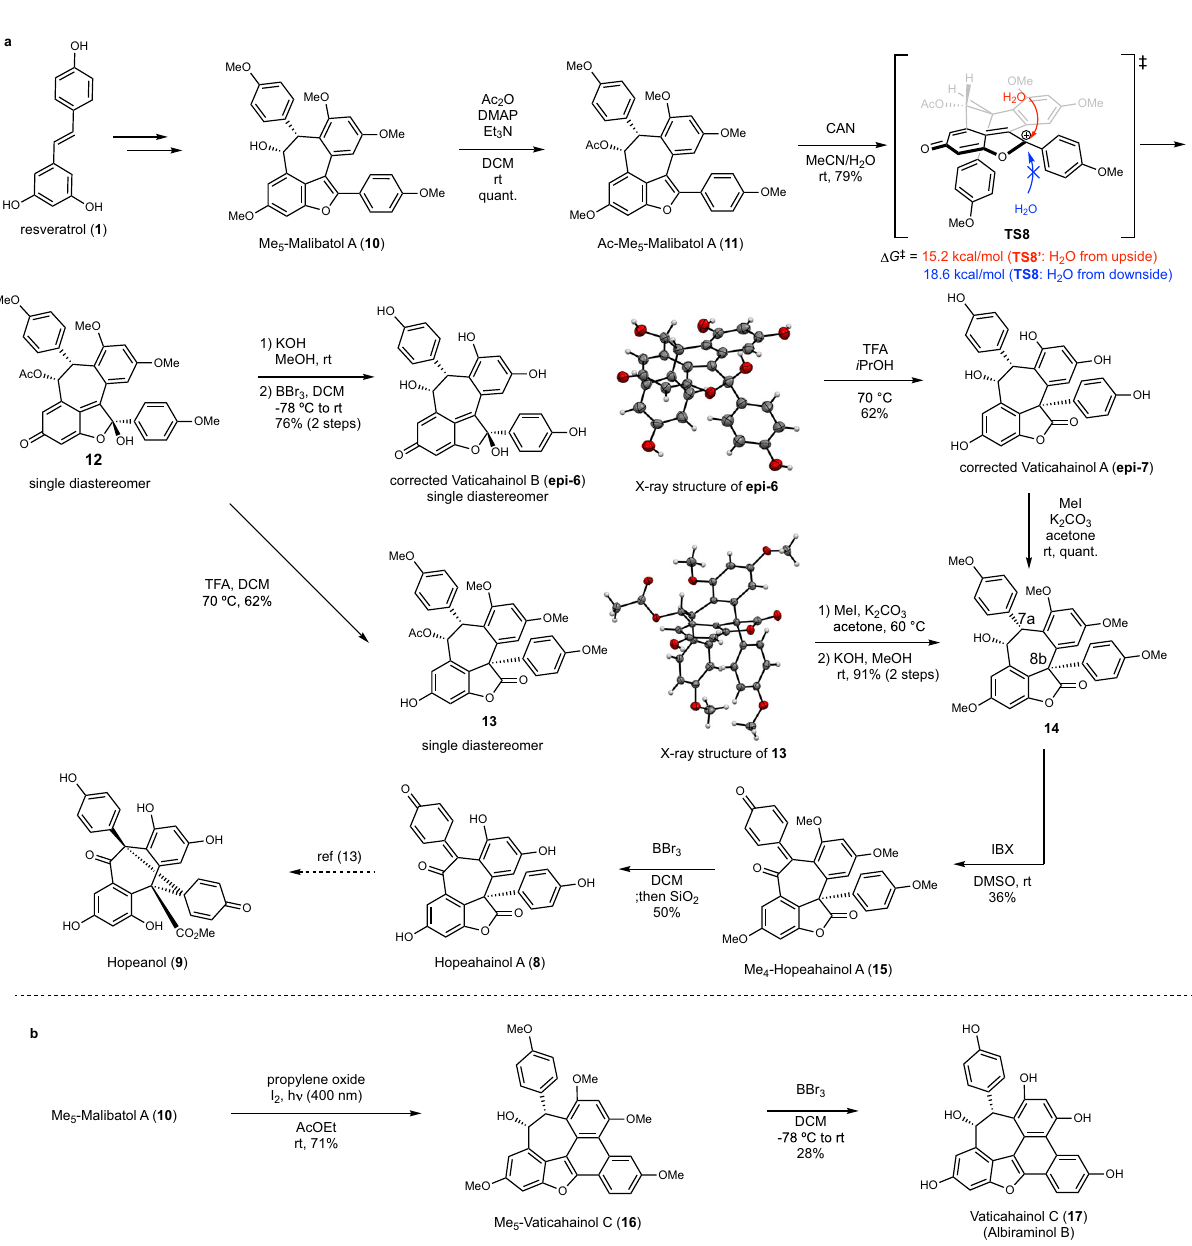
Fig. 3 Total syntheses of resveratrol dimers. a Total syntheses of corrected vaticahainol A ( epi-7 ), vaticahainol B ( epi-6 ), and hopeahainol A. b Total syntheses of vaticahainol C (albiraminol B). DMAP 4-dimethylaminopyridine, DCM dichloromethane, CAN cerium (IV) ammonium nitrate, TFA tri fl uoroacetic acid, IBX 2-iodoxybenzoic acid, DMSO dimethyl